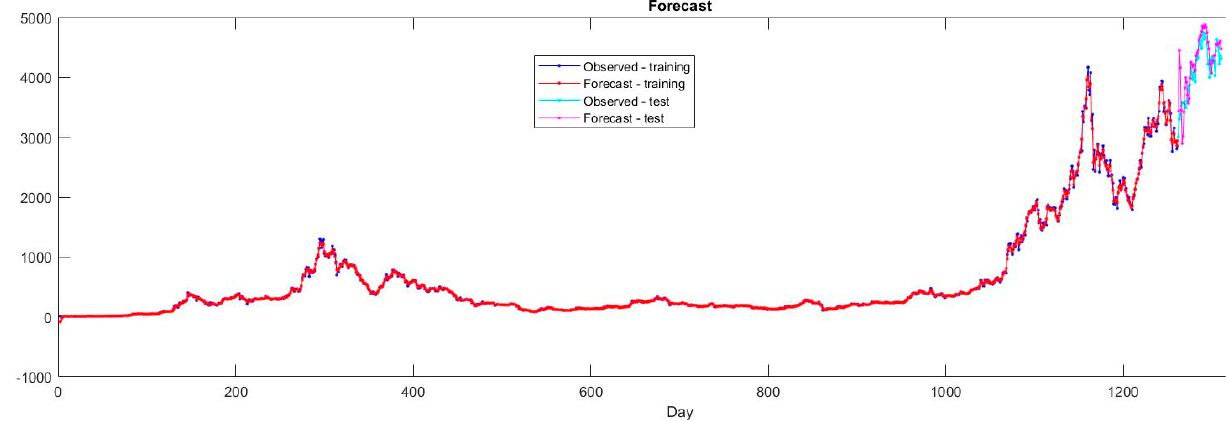
Figure 22. ETH–USD: LSTM–ADAM optimizer training.